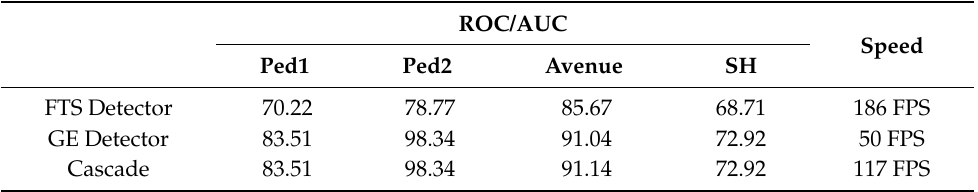
Table 4. Frame-level ROC/AUCs of the cascaded detector on multiple